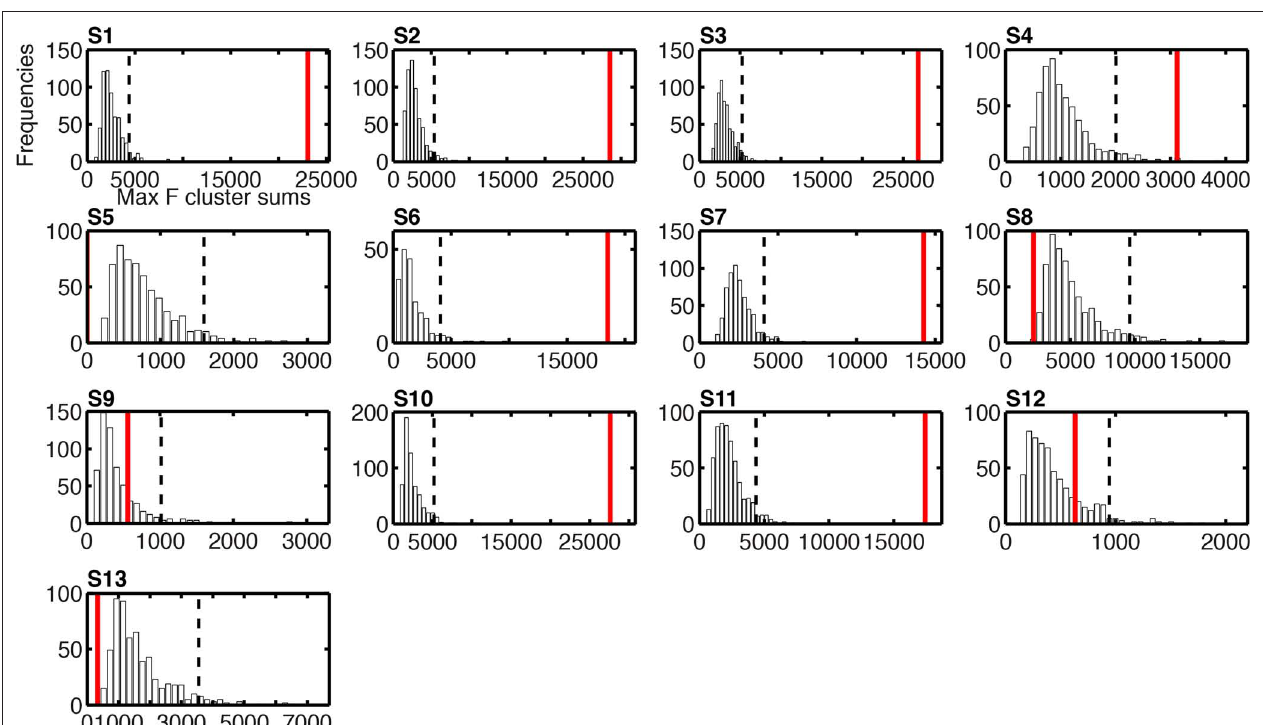
FiGuRE 11 | Histograms of the bootstrap distributions of maximum F cluster sums for task effects on single-trial ERP noise sensitivity. The subject number is indicated by S# in bold font. These bootstrap distributions were calculated under the null-hypothesis H0, as described in Methods; hence they reflect the size of spatial–temporal task effects that can be expected by chance, due to random sampling, across the entire search space. For each